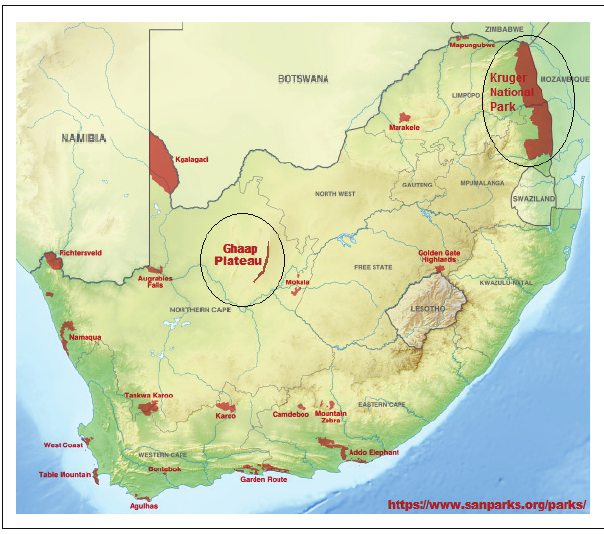
FIGURE 1: A modified map of South Africa detailing the National Parks. The two circled areas represent the anthrax-enzootic areas (Kruger National Park and the Ghaap